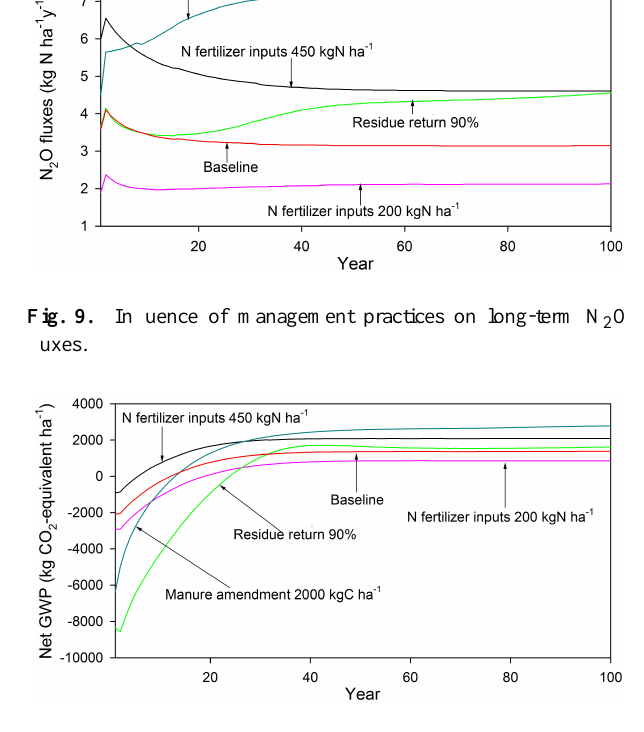
Fig. 10. Influence of management practices on long-term net